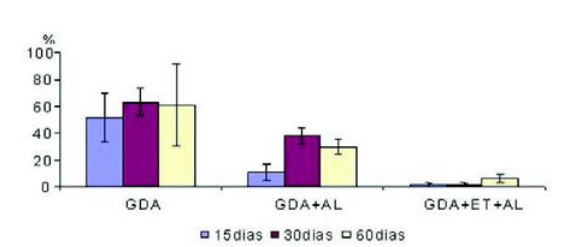
Análise da calcificação dos condutos pela